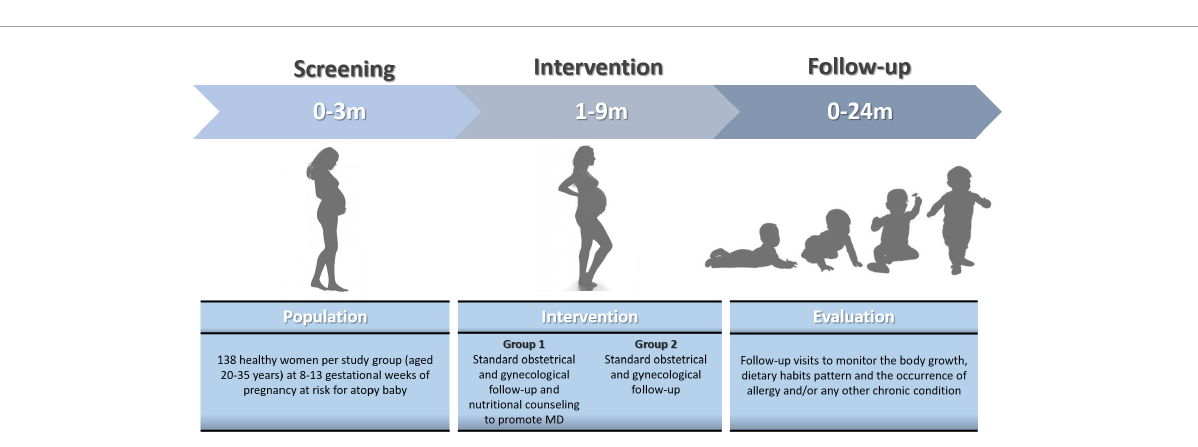
FIGURE3 The study plan. The figure show the time schedule of screening, intervention, and